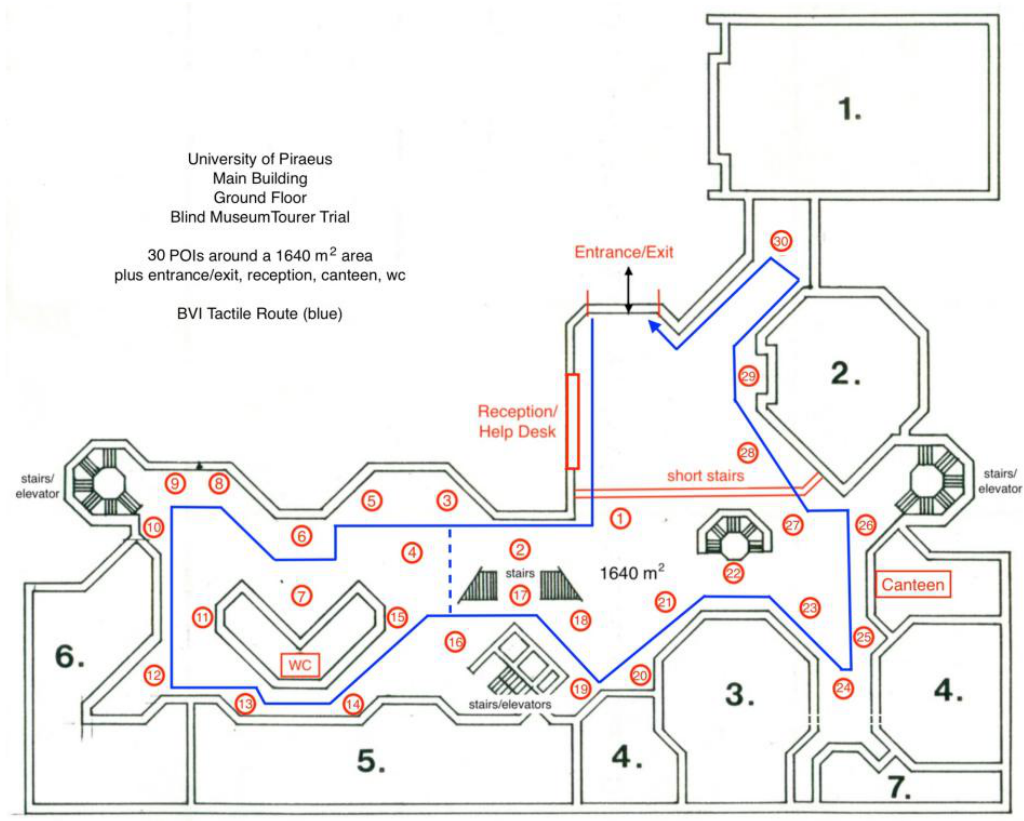
Figure 12. Blind MuseumTourer indoor navigation and guidance system preliminary trials.